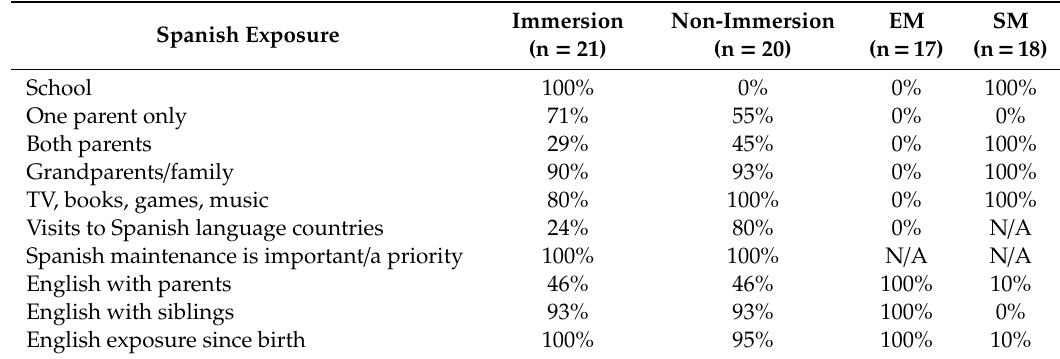
Table 1. Heritage children’s exposure to Spanish according to parent responses on the language background